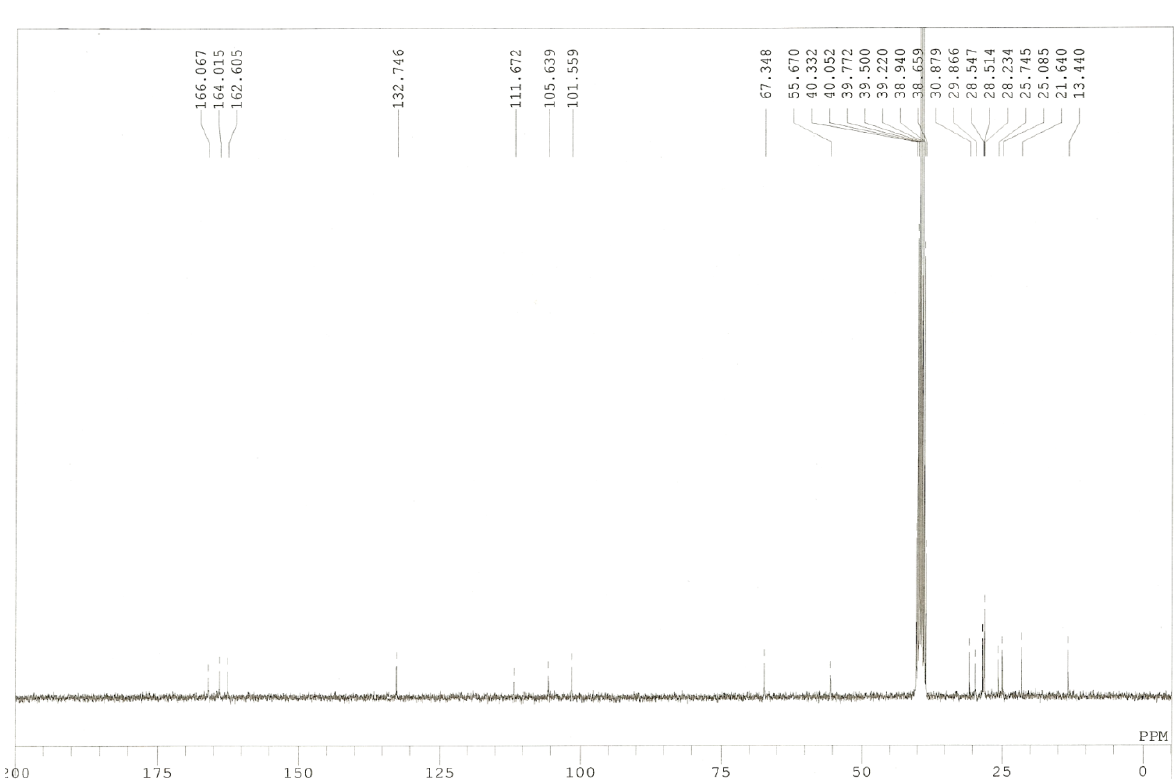
(LH ) (NO ) ](NO 2 2 3 3 4